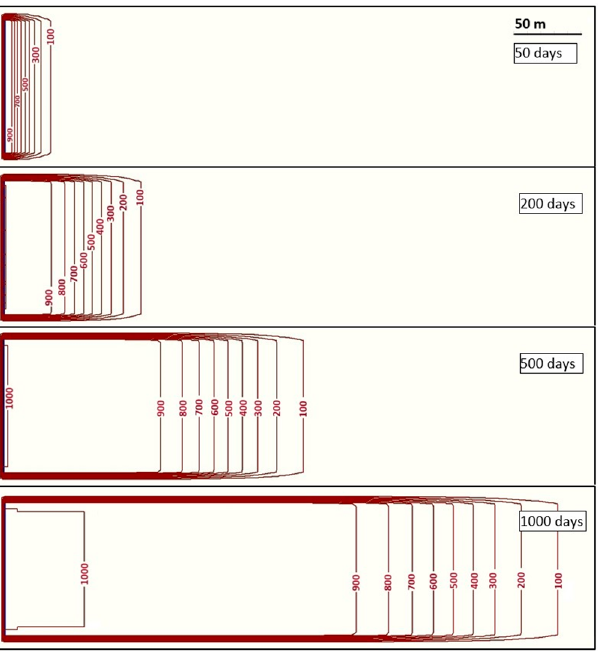
Figure 3. Iso-concentration patterns for times 50, 200, 500 and 1000 days in a large horizontal scenario due to advection (without diffusion).